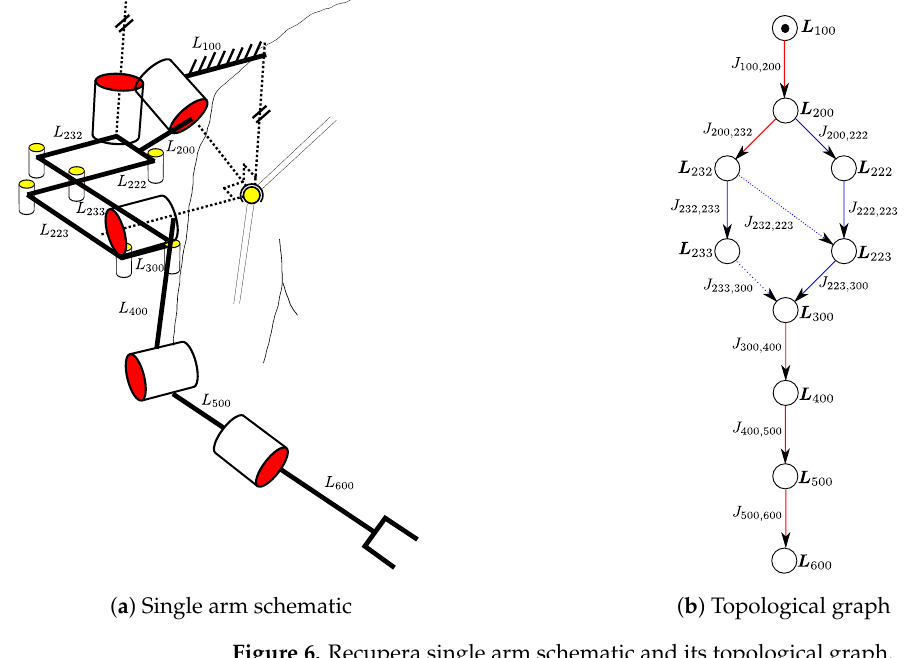
Figure 6. Recupera single arm schematic and its topological graph.